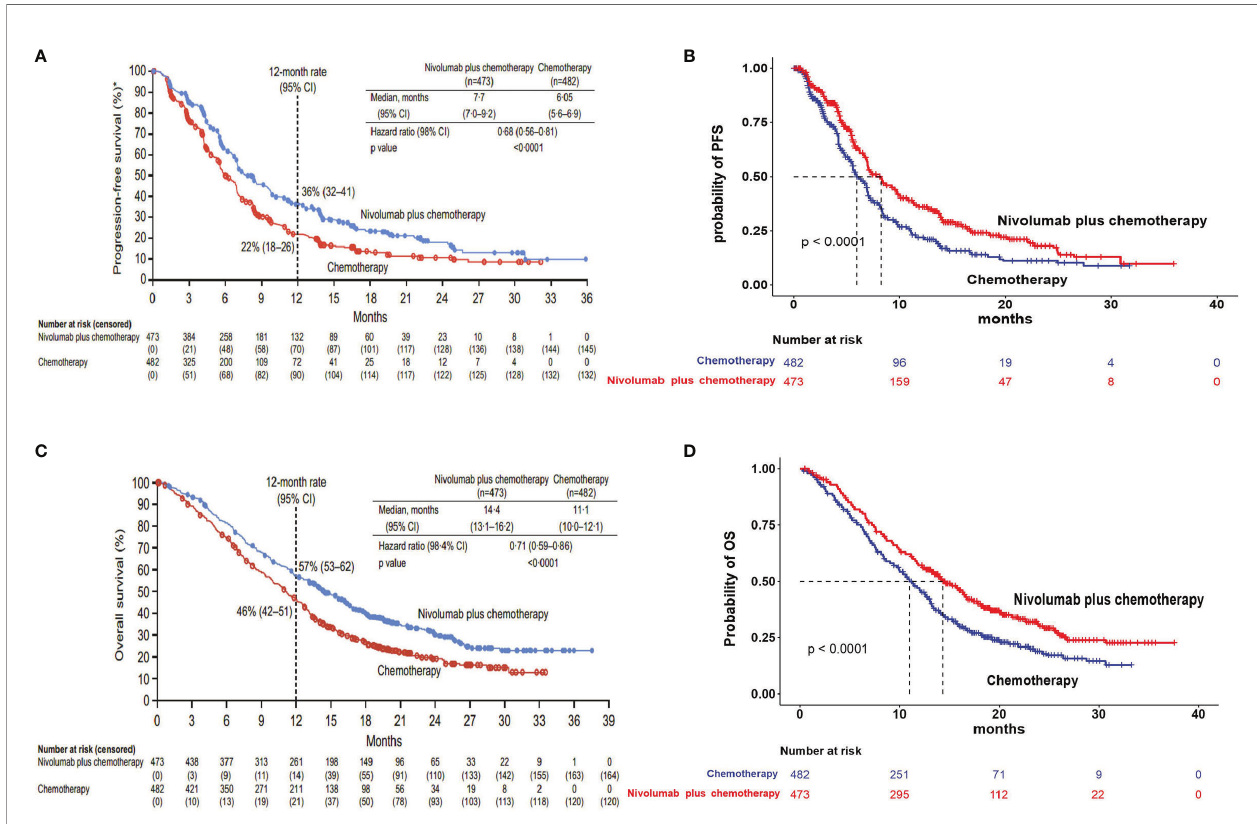
FIGURE 2 | Model estimated PFS and OS were plotted, together with the original Kaplan – Meier PFS and OS curves from the CheckMate 649 trial, respectively. (A) Kaplan – Meier curve of the progression-free survival from the CheckMate 649 trial. (B) Simulate progression-free survival curve for the nivolumab plus chemotherapy and chemotherapy. (C) Kaplan – Meier curve of overall survival from the CheckMate 649 trial. (D) Simulate overall survival curve for the nivolumab plus chemotherapy and chemotherapy. PFS, progression-free survival; OS, overall survival.